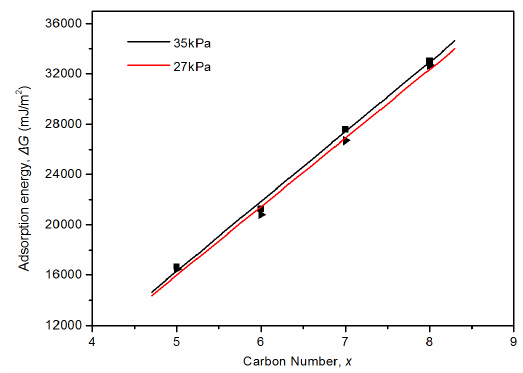
Figure 2: The effect of inlet pressure of column (Sample B)